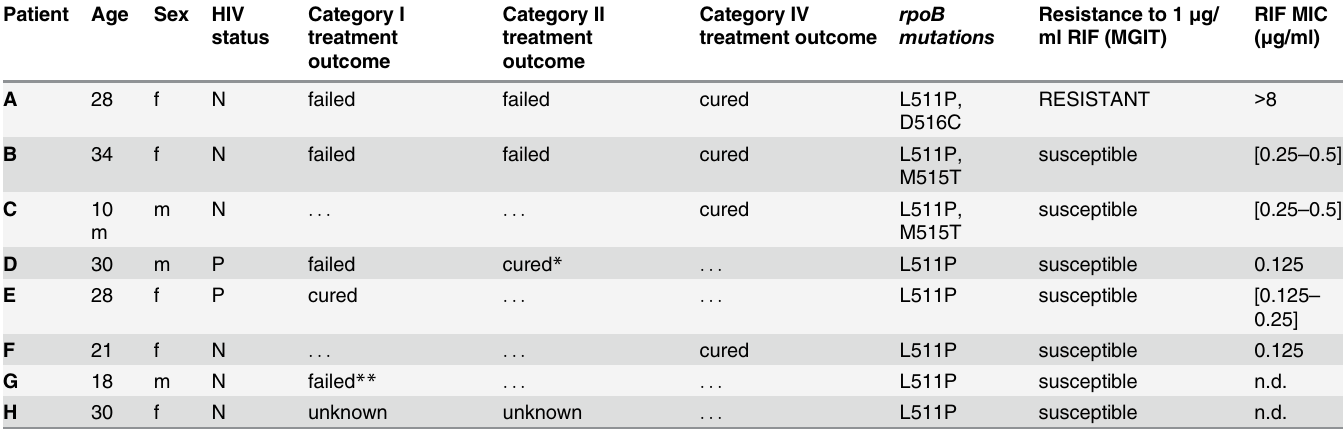
Table 1. Clinical and microbiological characteristics of 8 patients in L511P